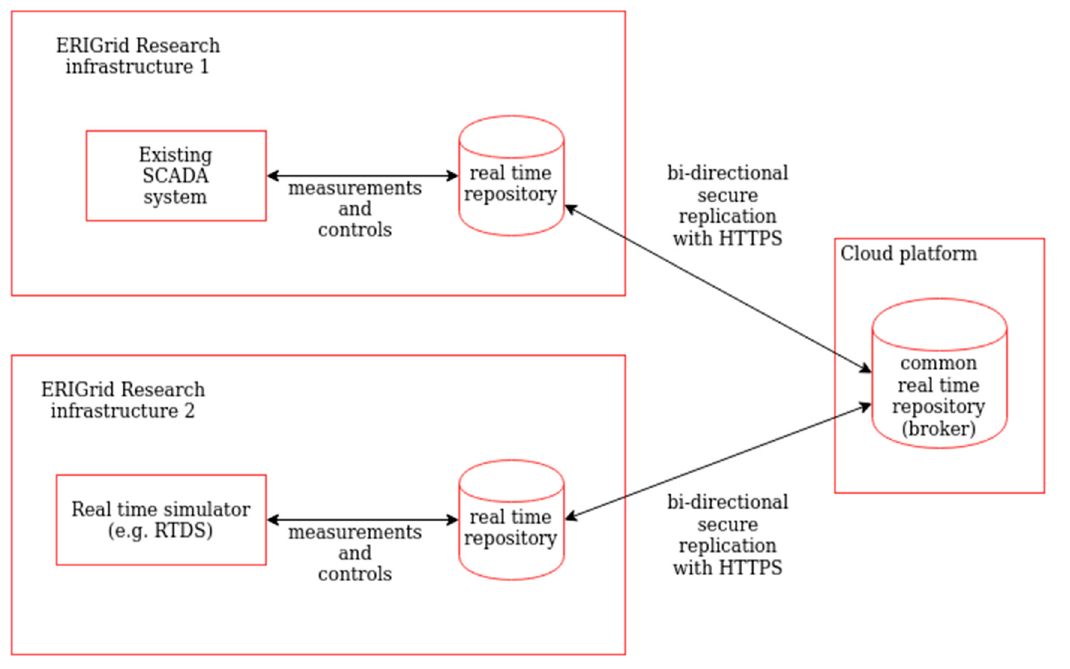
Figure 2. Joint Test Facility for Smart Energy Networks with Distributed Energy Resources (JaNDER) Level 0 architecture.